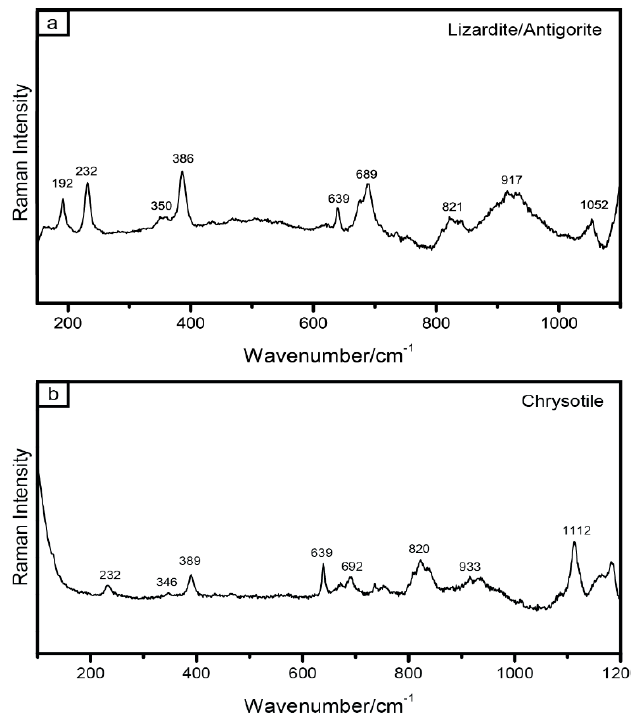
Figure 9. Raman spectra in the low-wave number region of ( a ) mixed lizardite and antigorite and ( b ) chrysotile.